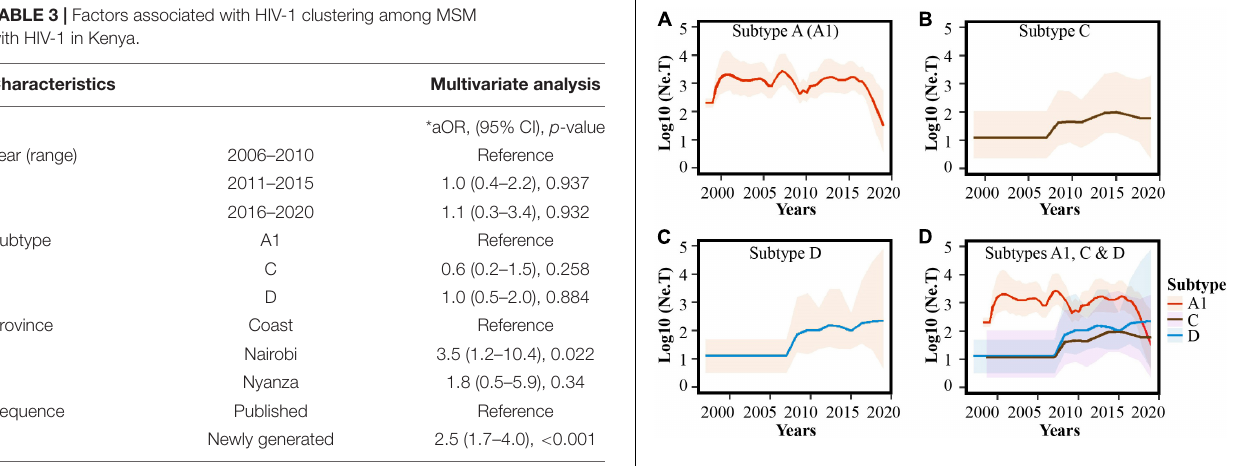
FIGURE 3 | Population dynamics of HIV-1 sub-subtype A1, subtype D, and subtype C lineages among MSM in Kenya. Bayesian Skygrid plots showing population dynamics of the (A) HIV-1 sub-subtype A1, (B) HIV-1 subtype C, (C) HIV-1 subtype D lineages, and (D) combined plots for HIV-1 A1, C and D lineages in Kenyan MSM. Median estimates of the number of MSM contributing to new infections are shown as a continuous line in each plot (colored red for sub-subtype A1, brown for subtype C, and blue for subtype D). The shaded area represents the 95% higher posterior density intervals of the inferred effective population size for each